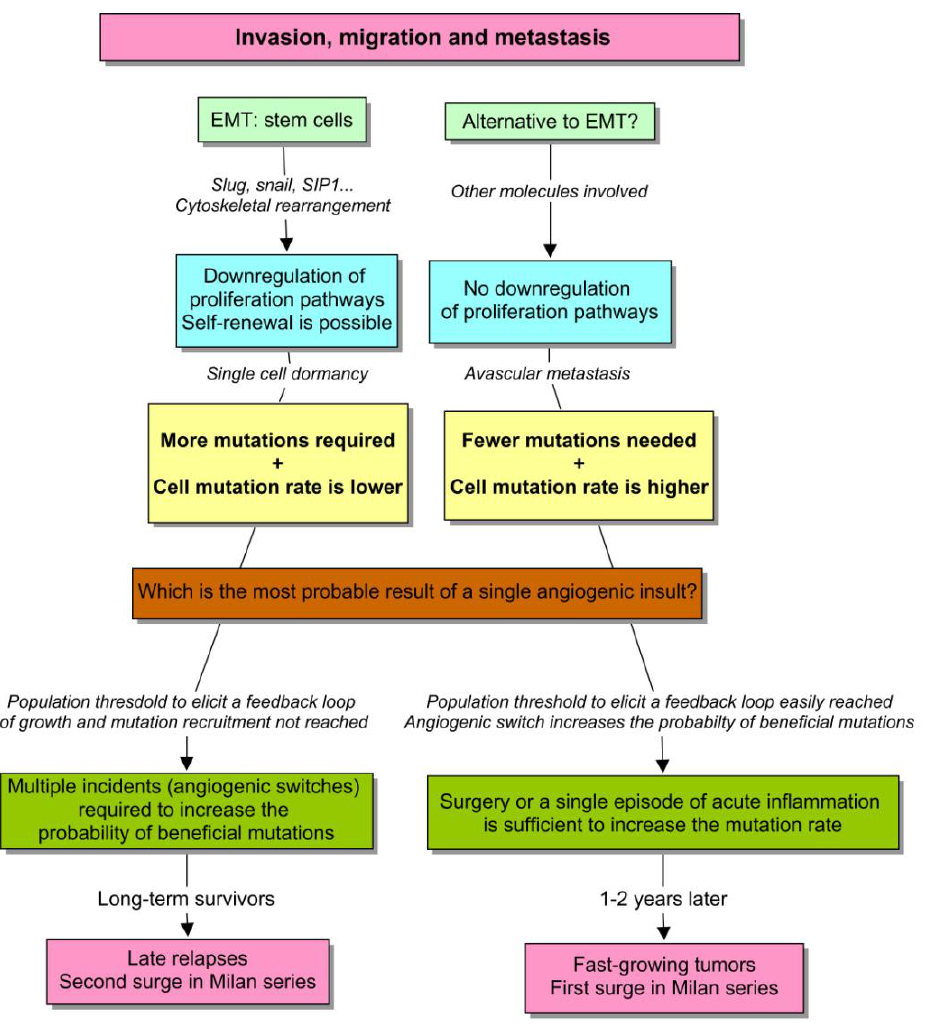
Figure 5. Amplifier feedbacks in the evolution of dormant tumors. The discrete behavior in the Milan series can be explained by a positive feedback loop that amplifies the effect of a short-lived angiogenic insult. Any population growth, even though it is small, implies that the mutation rate increases to a certain extent. Therefore, the mutational upregulation of angiogenesis and proliferation pathways is more likely to develop. This upregulation closes the circle and allows a more rapid recruitment of other metastasis progression genes. However, the population increments as responses to the same angiogenic stimulus are unequal, and depend on the cell ability to proliferate during the burst of